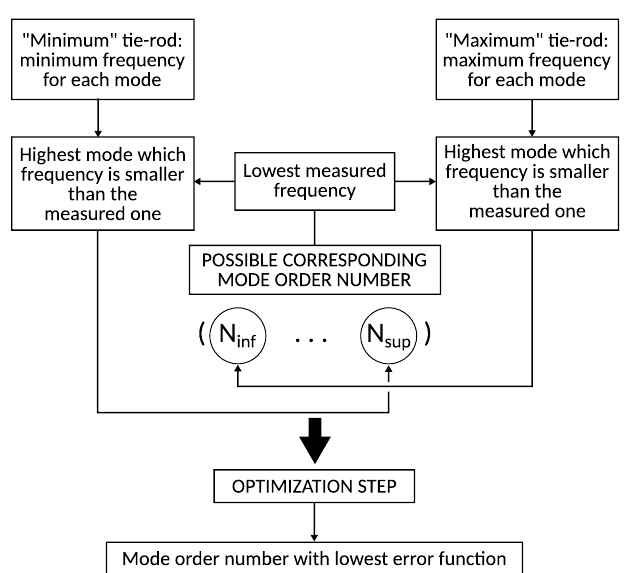
Figure 11. Mode order number guessing heuristic: procedure to be used when measuring with sensors of unknown frequency